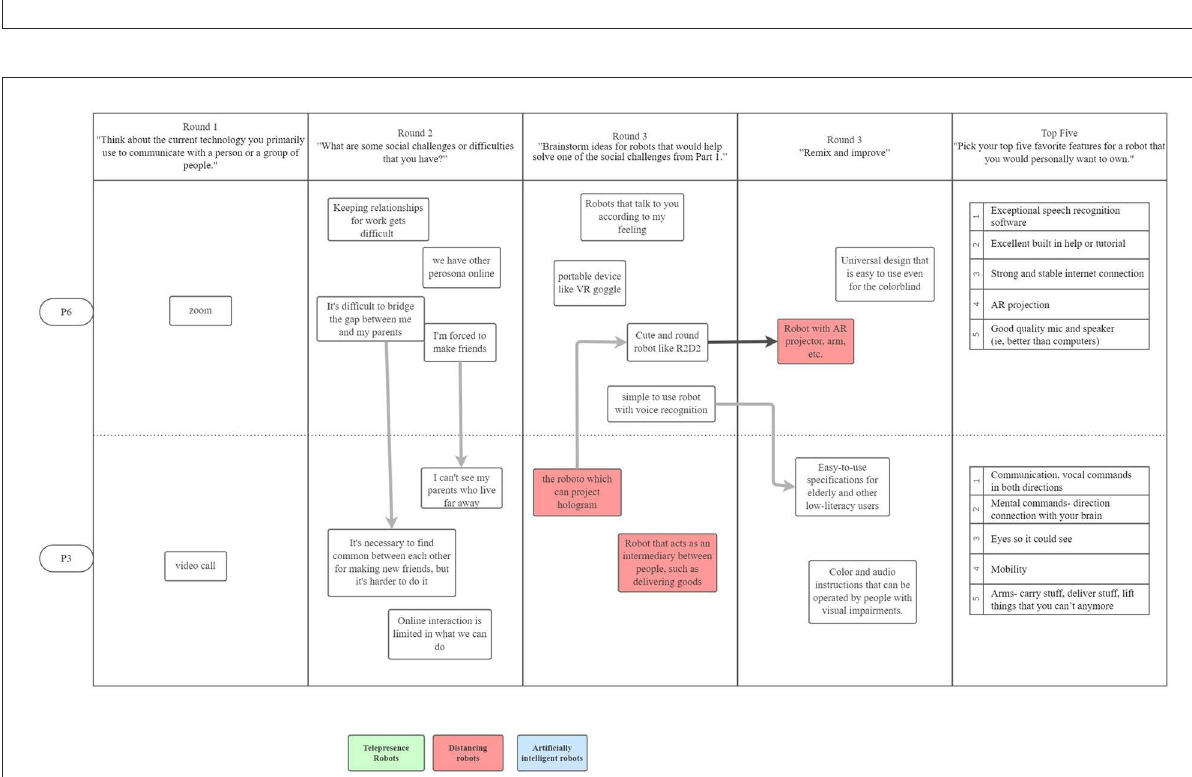
FIGURE3 The third US PD session was held on December 4, 2020 and had 2